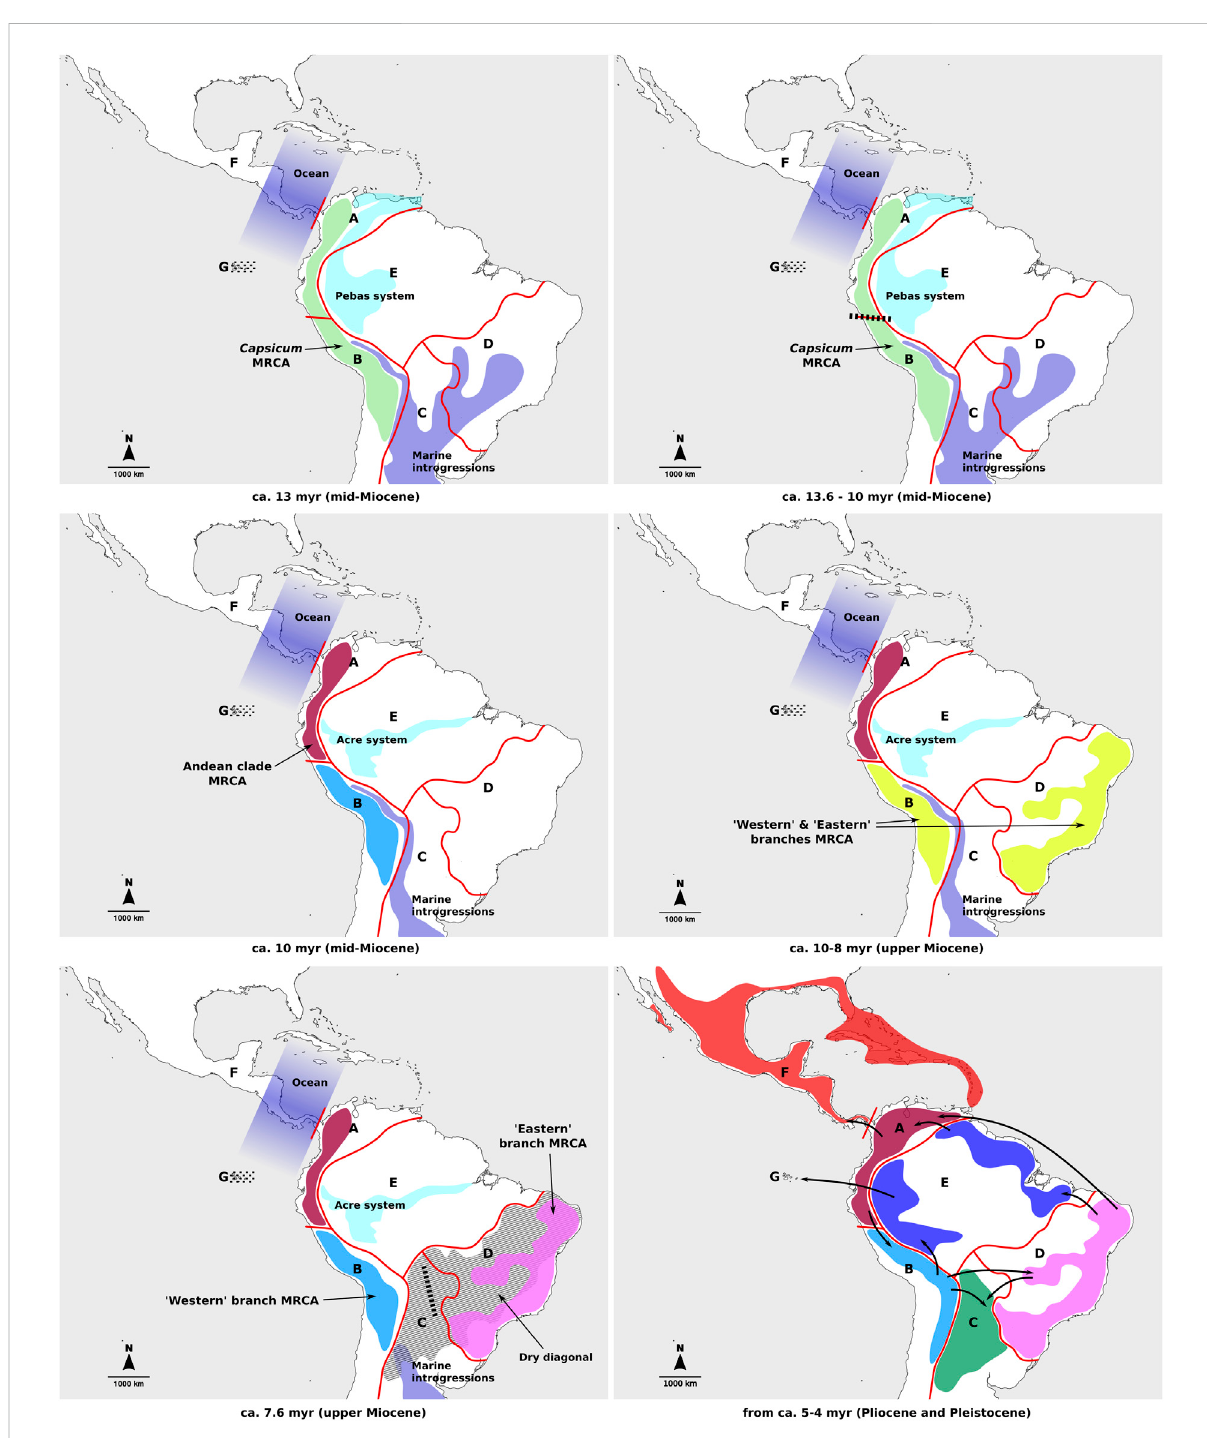
FIGURE 4 Main events of Capsicum spatial diversi fi cation through time. Different colors represent current distribution ranges per area. Geographic areas indicated on the fi gures: A, Northern Andes; B, Central Andes; C, Chaco, D, southeastern South America; E, Amazon basin; F, Central America and southern United States; G, Galápagos Archipelago. Dotted lines indicate islands that are yet to emerge; dashed lines – vicariant events; bold arrows – dispersal